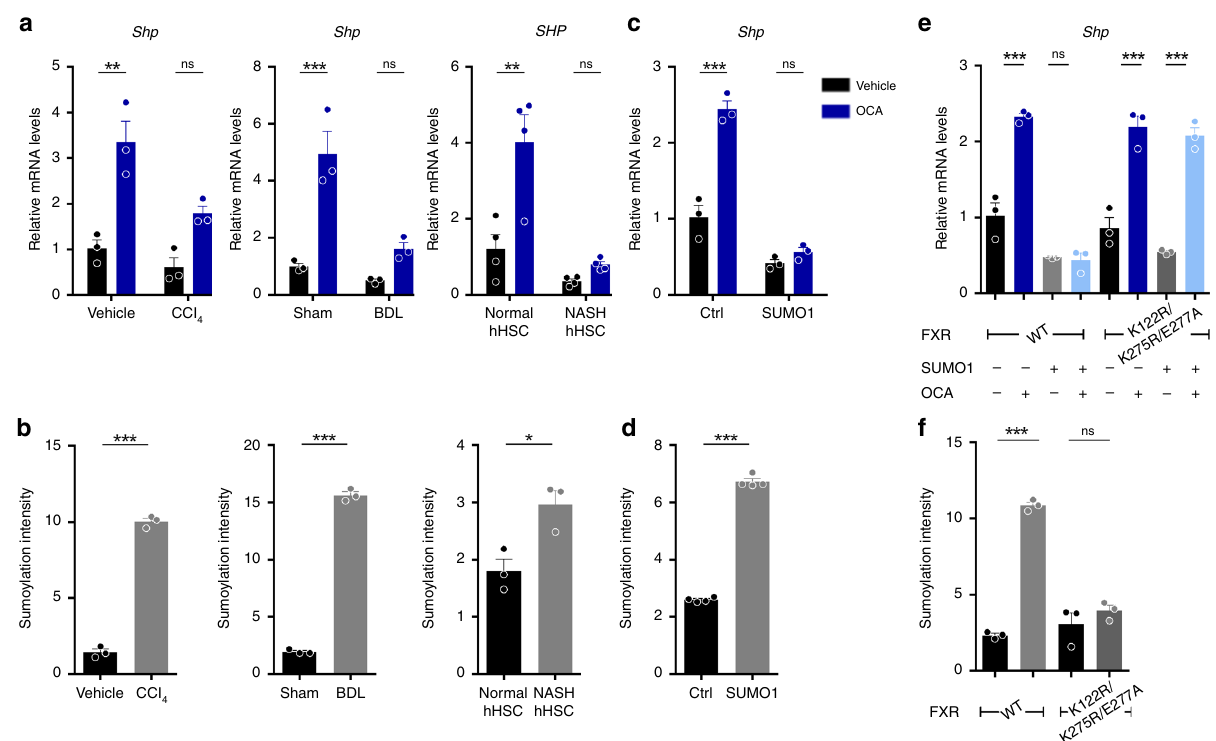
Fig. 4 Elevated SUMOylation of FXR in activated HSCs represses its transcriptional activity. a OCA failed to induce the expression of SHP in activated HSCs, caused by CCl 4 treatment, BDL operation, and from NASH patients. b SUMOylation of FXR elevated in activated HSCs, caused by CCl 4 treatment, BDL operation, and from NASH patients, as analyzed by Protein SUMOylation Assay Ultra Kit. c , d Shp mRNA levels c and FXR SUMOylation d in cells transfected with SUMO1 plasmid. e , f Shp levels e and FXR SUMOylation f in cells transfected with WT or SUMO-site mutant FXR plasmid together with SUMO1 plasmid ( n = 3 biologically independent samples within these experiments). Results are mean ± SEM, * P < 0.05, ** P < 0.01, *** P < 0.001, and ns, statistically not signi fi cant, as assessed with Student ’ s t -test or